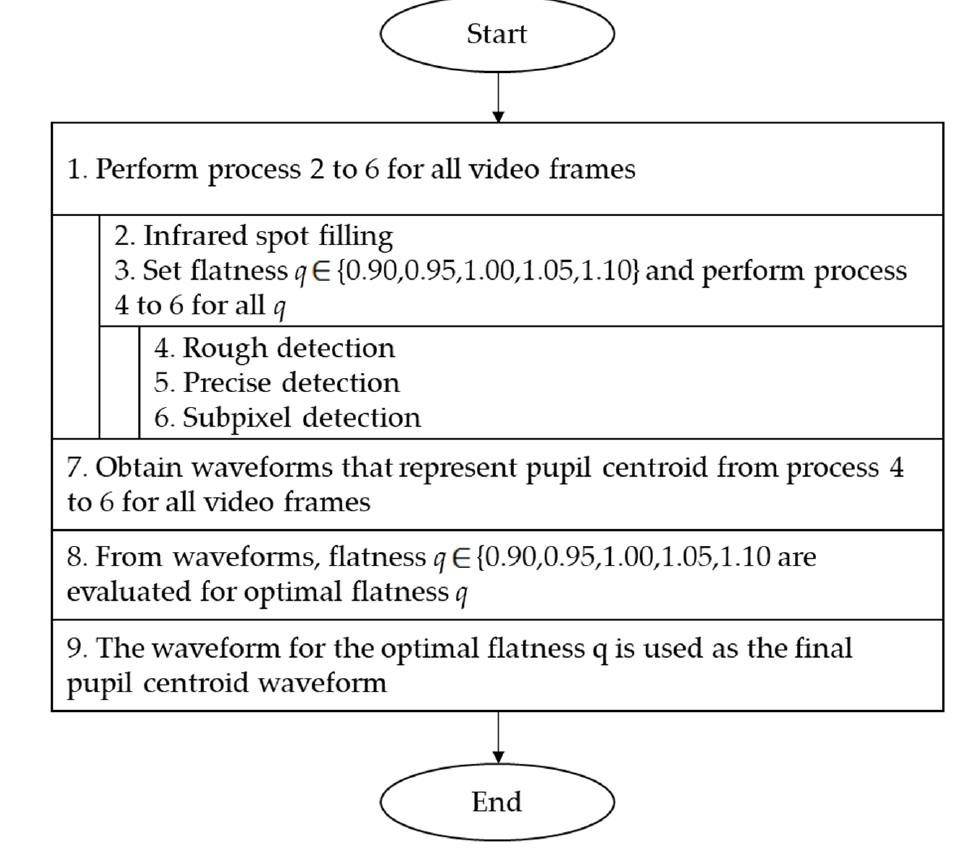
Figure 3. Design of proposed method.